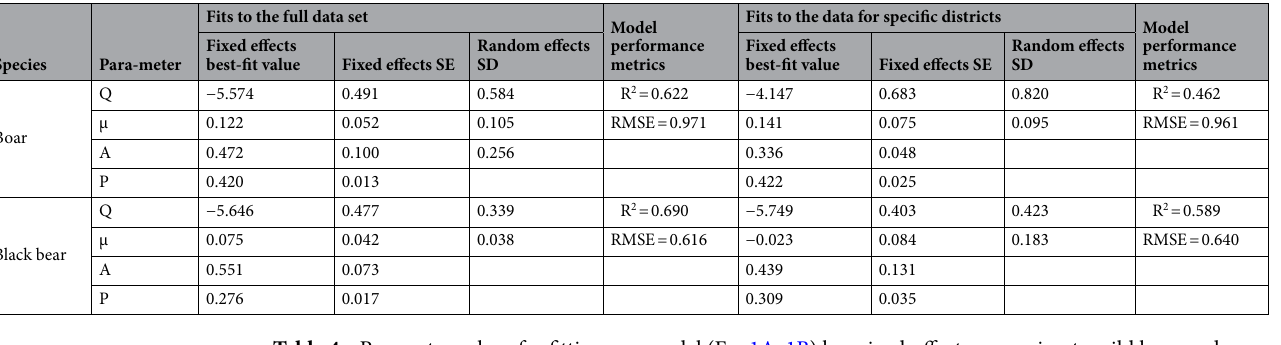
Table 4. Parameter values for fitting our model (Eq. 1A, 1B) by mixed-effects regression to wild boar and Asian black bear data. The preferred mixed-effects model structure for each data set was selected based on several criteria described in the main text. Random effects for selected parameters were allowed to vary by district and municipality within district, and the variance was allowed to be different for each district. SE represents standard errors and SD represents standard deviations.